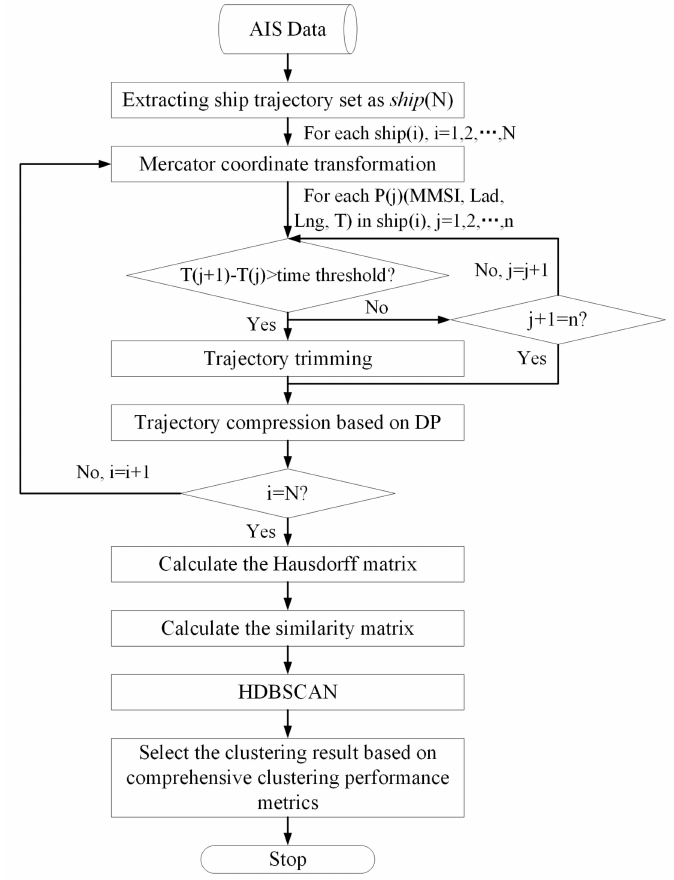
Figure 4. Flowchart of HDBSCAN based ship trajectory clustering.